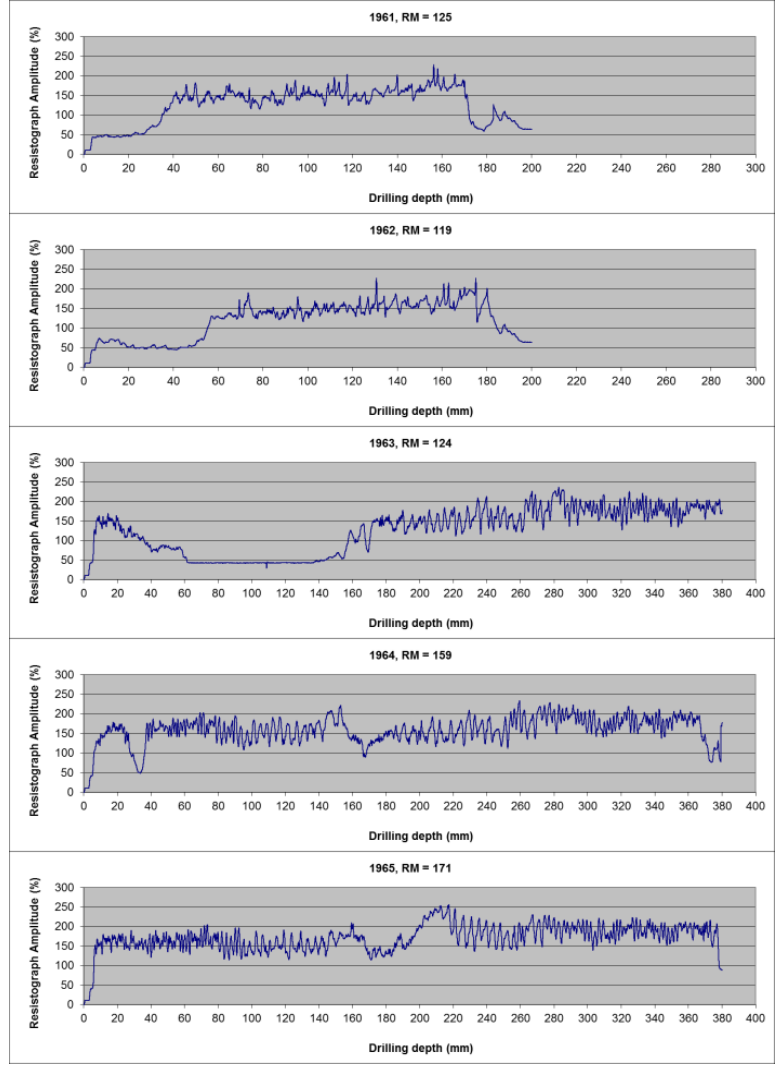
Figure 11. Graphic records from the individual points of measurement by Resistograph, beam (H2), measured parallel to the orientation of the pin at the bottom of the beam.